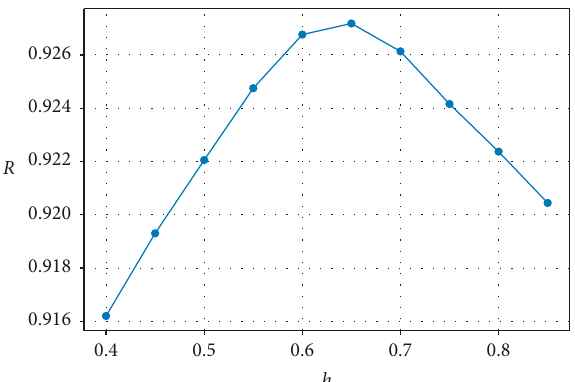
Figure 8: Hybrid mode is a mix of direct and hierarchical structures. A parameter h is used as the probability that a node will report to the local coordinator if disrupted. The plot is the mean of the resilience curve as a function of h . The optimum value of the parameter for this network is 0.65, meaning that the probability of a disrupted node reports to the local coordinator is 65%.